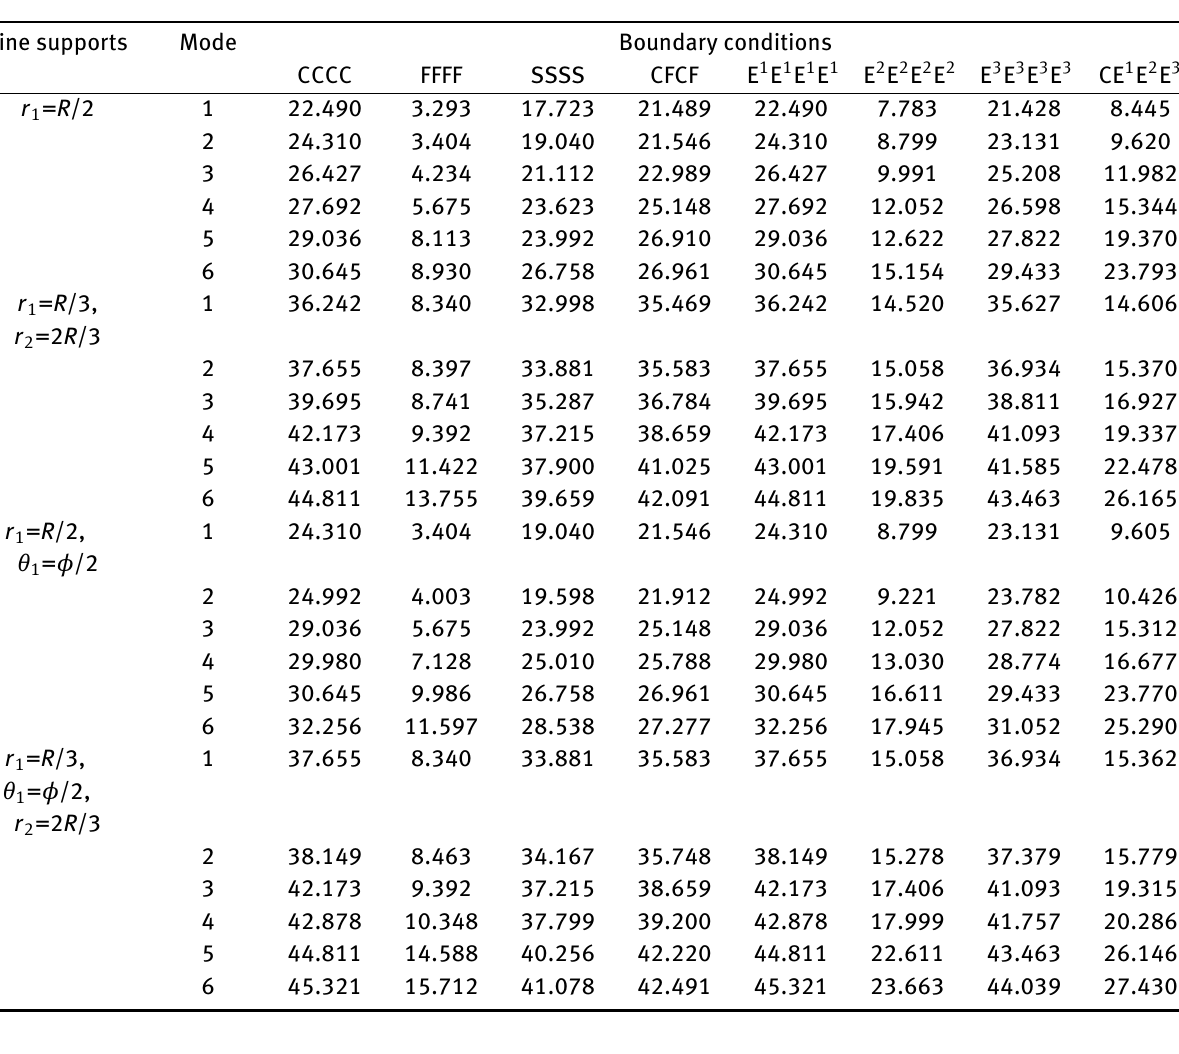
Table 9: The first five frequency parameters Ω for a four-layered, [90 ∘ /0 ∘ /0 ∘ /90 ∘ ] annular sector plate with different boundary conditions and various line supports ( a / b =0.2, h / b =0.1, ϕ = π , E 1 / E 2 =15). Line supports